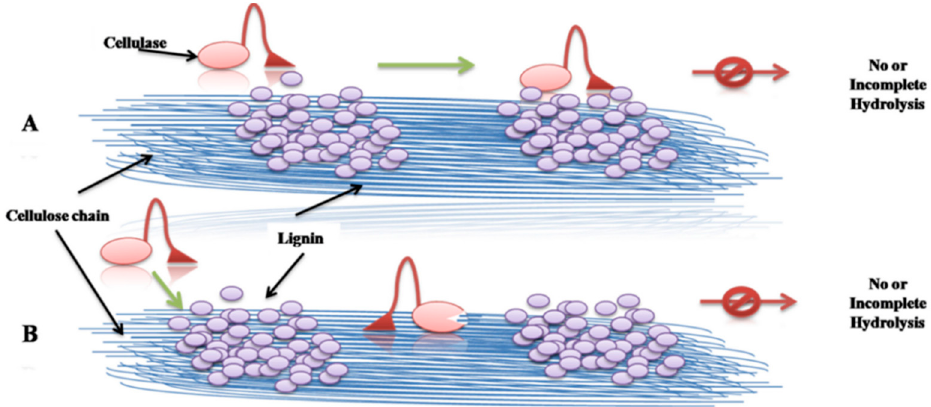
Figure 4. Lignin inhibition on cellulase. ( A ). Non-productive adsorption of cellulase onto lignin; ( B ) Physical blockage of cellulase by lignin [41].